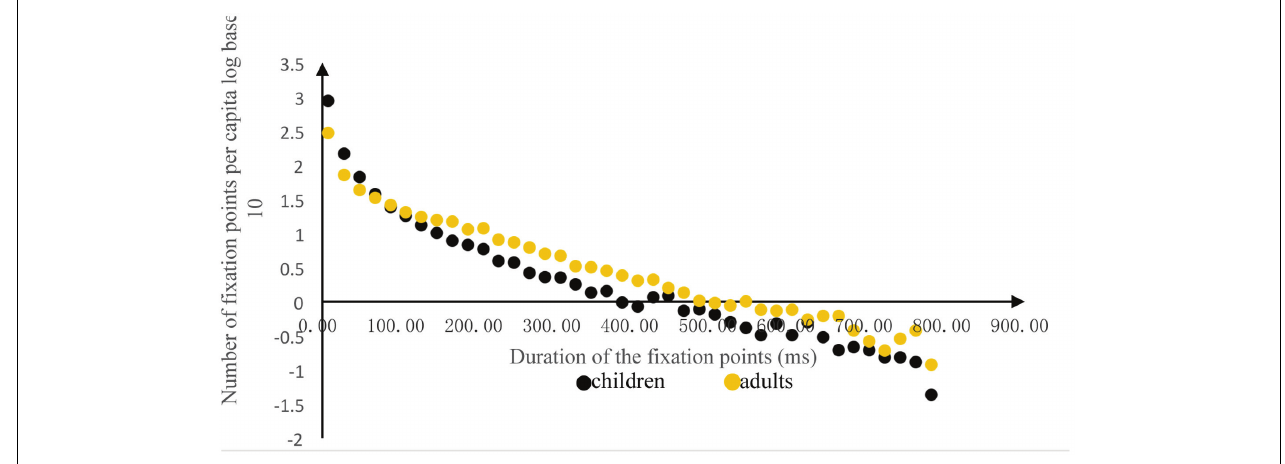
FIGURE 3 | Logarithmic distribution (log base 10) of the per-capita duration of different fixation